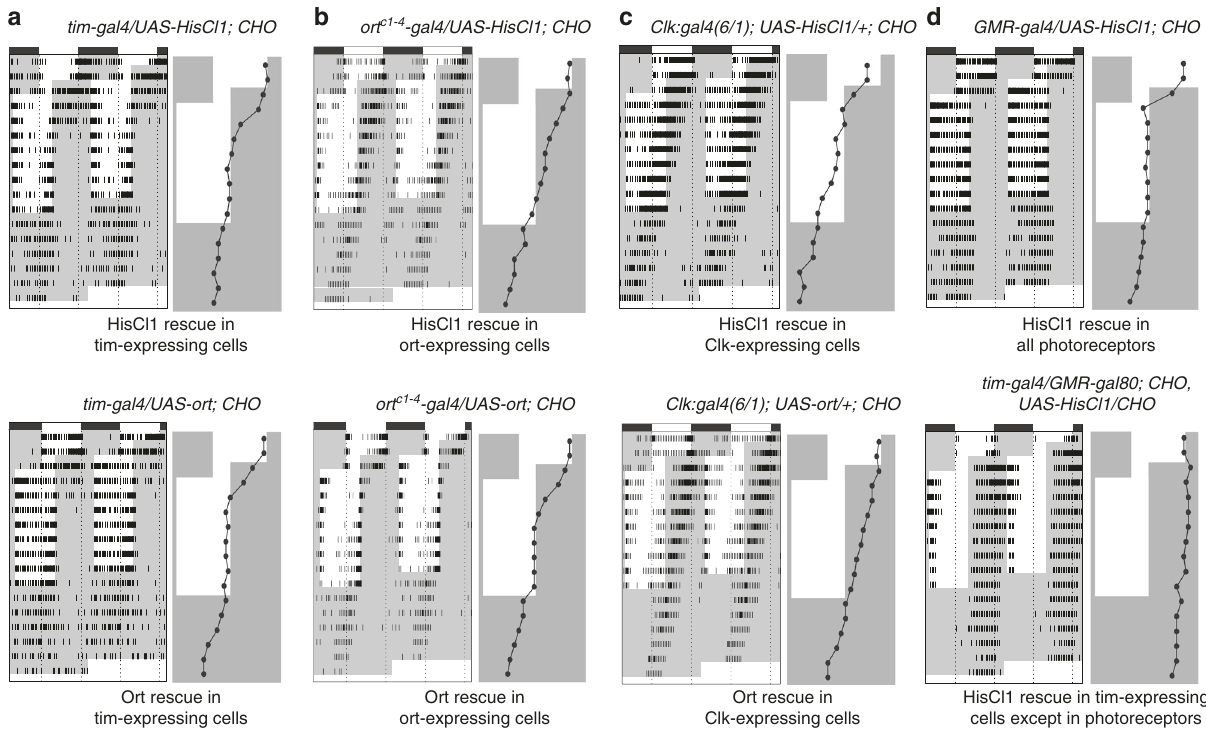
Fig. 2 Ort and HisCl1 de fi ne different neuronal pathways for clock synchronization. Actograms and phase plots of fl ies with expression of the two histamine receptors in the triple mutant ( HisCl1 134 ort 1 cry 02 – CHO ) genetic background using different gal4 drivers. The experimental design is as described in Fig. 1 legend. a Expression of either HisCl1 (top) or ort (bottom) in tim -expressing cells rescues entrainment. b HisCl1 cannot rescue entrainment when expressed in ort -expressing neurons (top), whereas ort can (bottom). c Neither HisCl1 (top) nor ort (bottom) rescues entrainment when expressed in most of the clock neurons. d Entrainment is rescued by HisCl1 expression in photoreceptors (top) and is not rescued by HisCl1 expression in tim -expressing cells when expression in the photoreceptors is blocked by the Gal4 inhibitor Gal80 ( GMR-gal80)